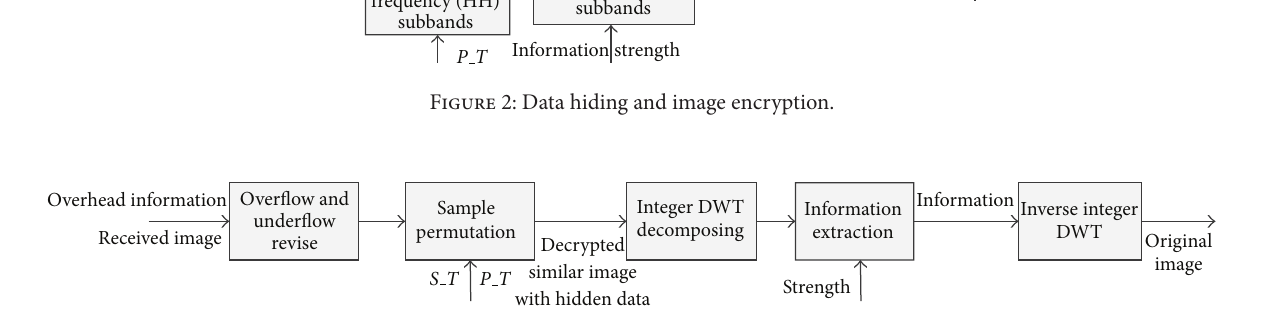
Figure 3: Data extraction and image